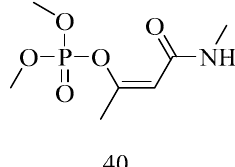
Figure 13. Monocrotophos.